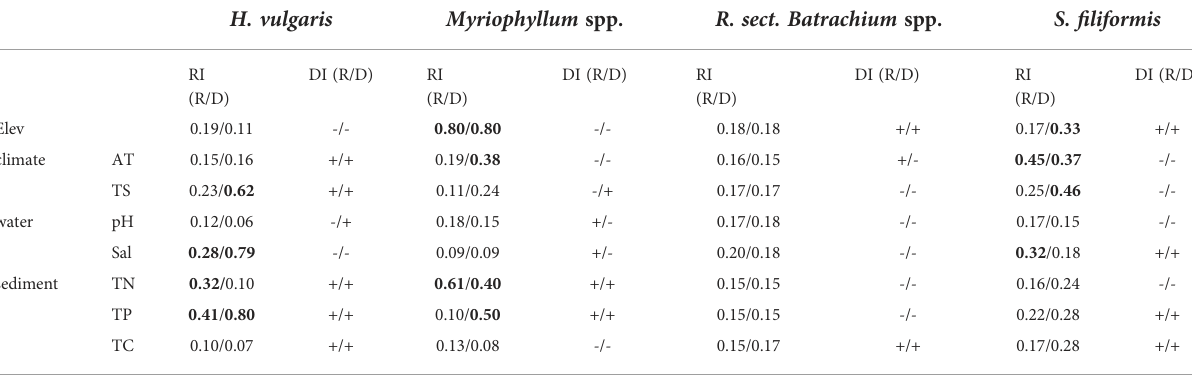
TABLE 3 Relative importance (RI) of environmental factors among all model